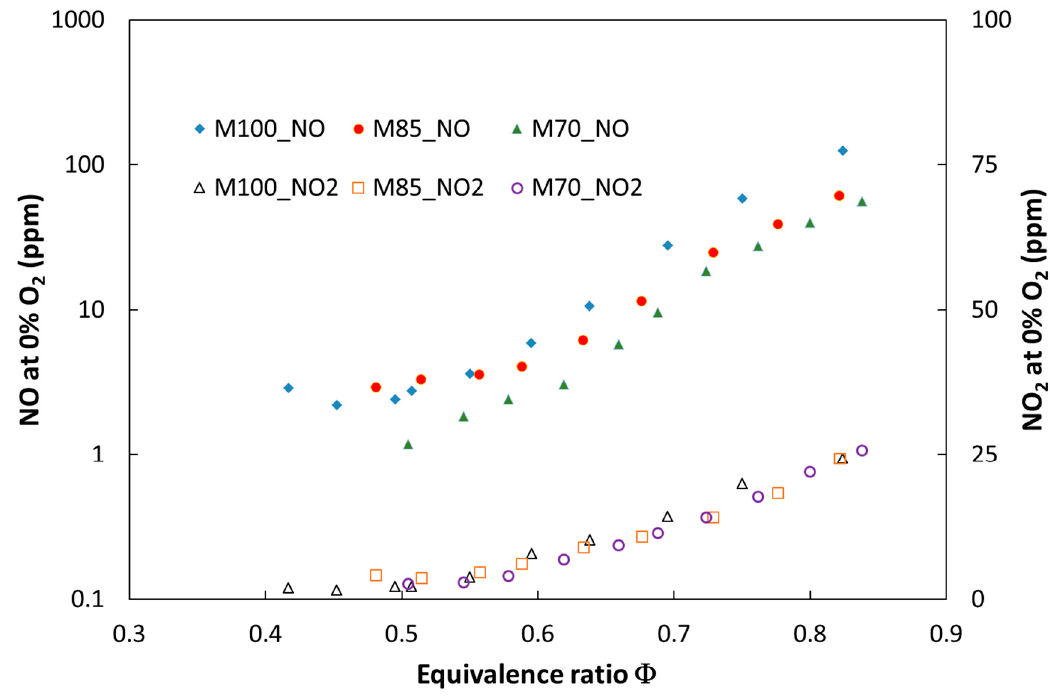
Figure 5. Experimental NO and NO 2 emissions for the tested fuels for atmospheric combustion pressure (P = 0.1 MPa) versus equivalence ratio.